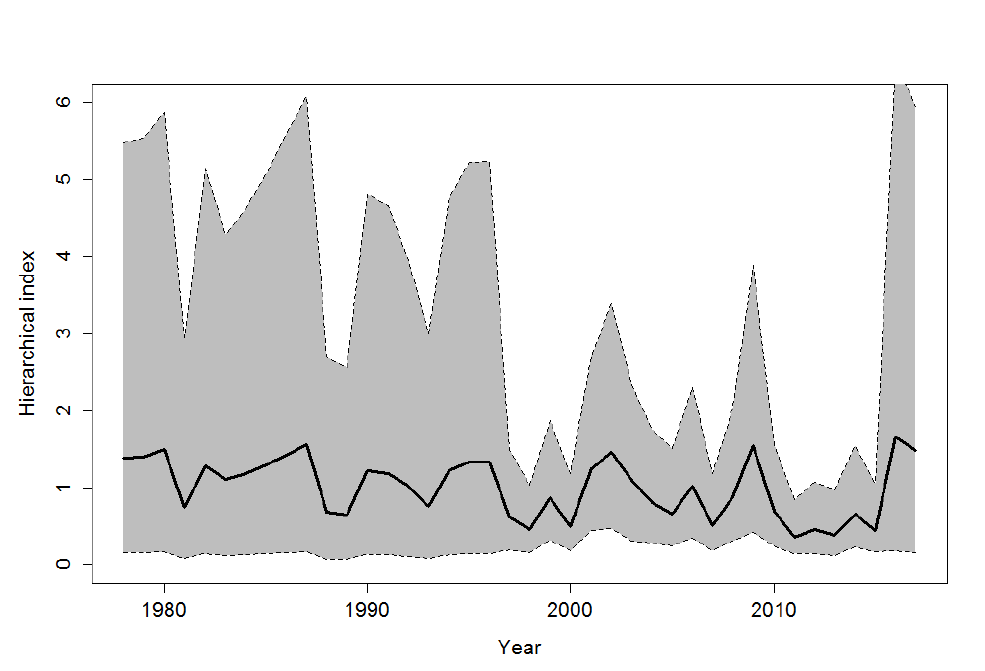
Figure 77. Time series of horseshoe crab relative abundance in the Northeast region as estimated from hierarchical analysis. The black line gives the posterior mean and the grey, shaded area represents a 95% credible interval about the time series.